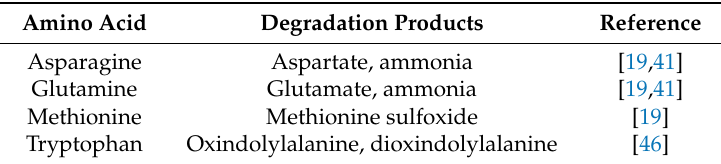
Table 2. Amino acid modification during acid